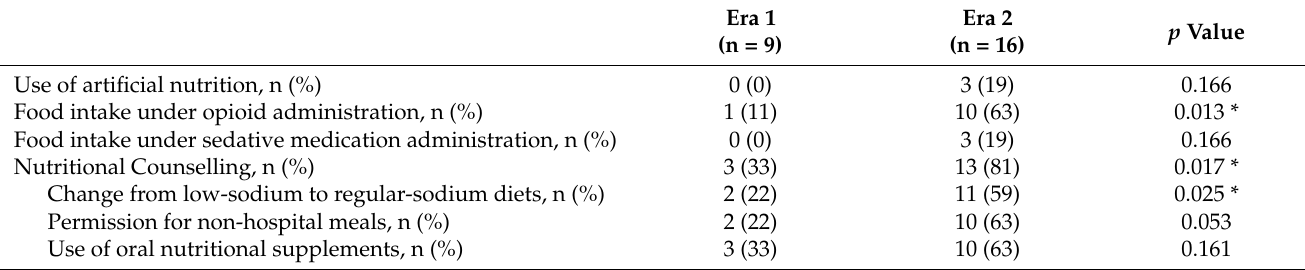
Table 3. Characteristics of patients who maintained oral intake in the three days prior to